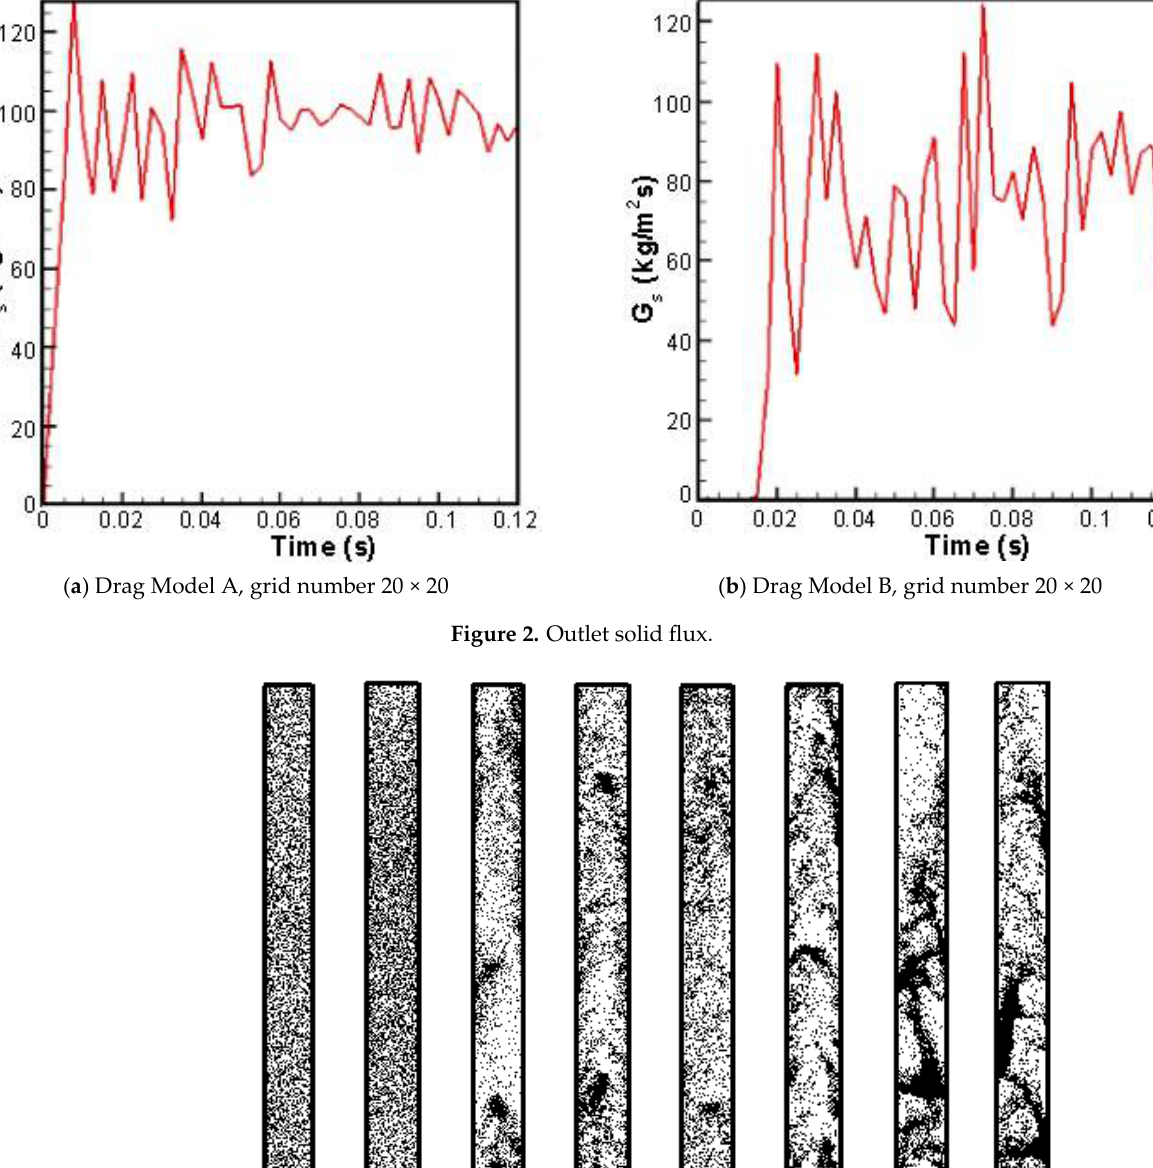
Figure 1. Particle location.